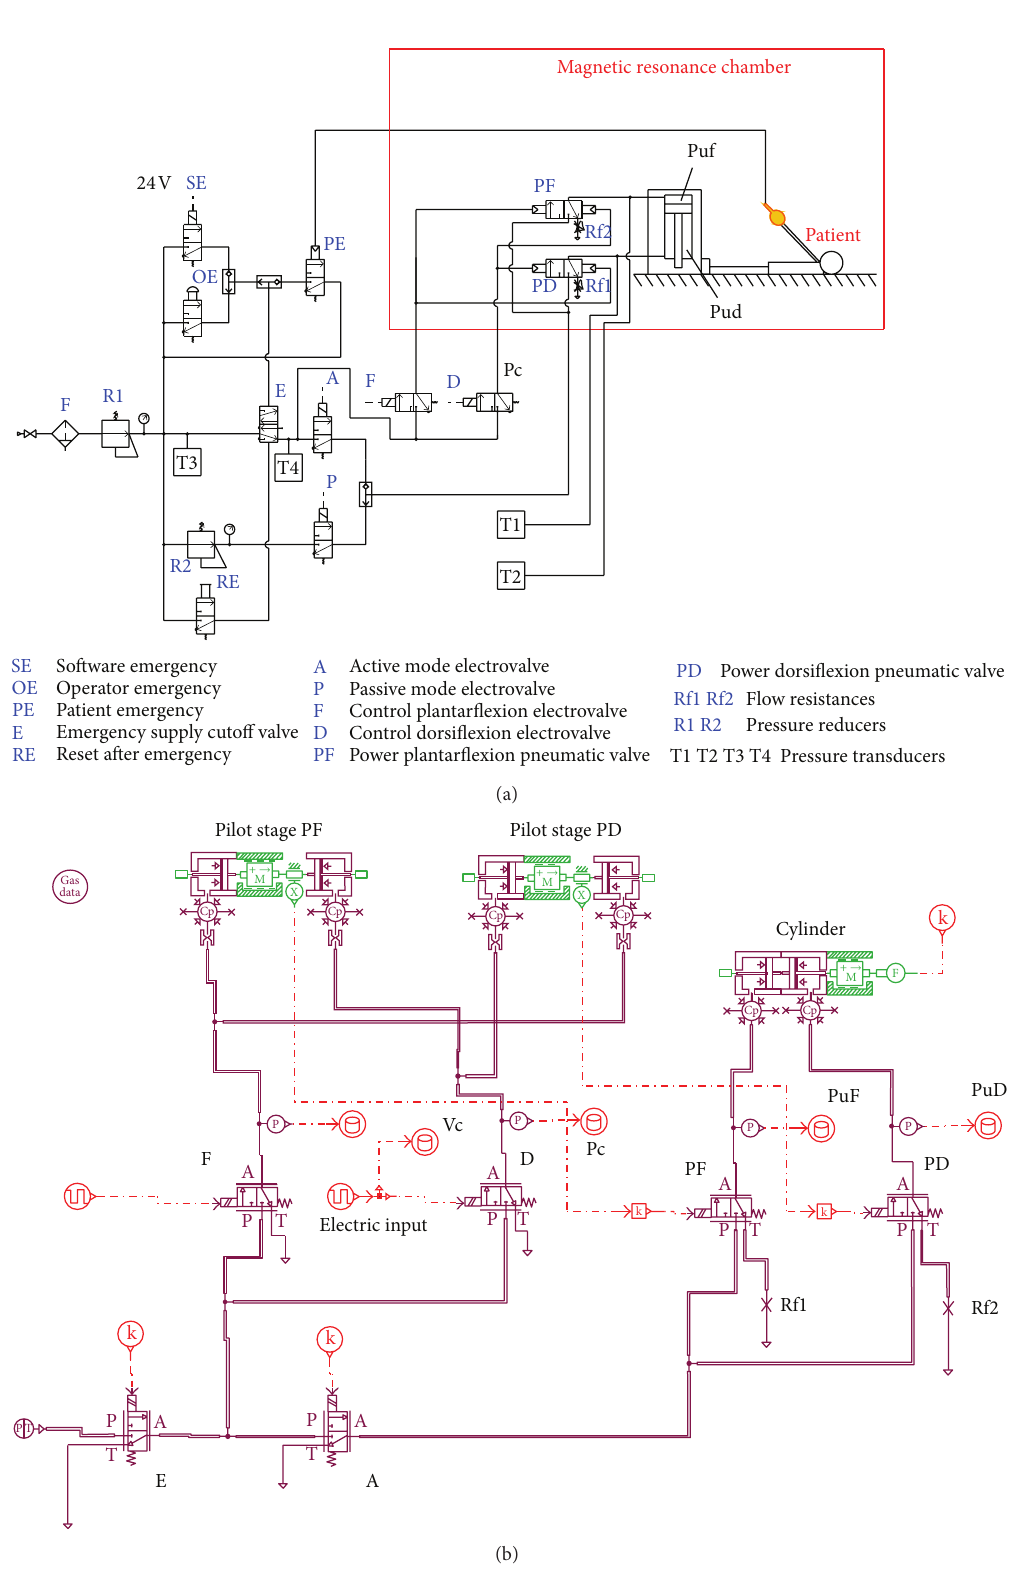
Figure 4: (a) Final electropneumatic control circuit. (b) Layout of the numerical model simulating the optimized